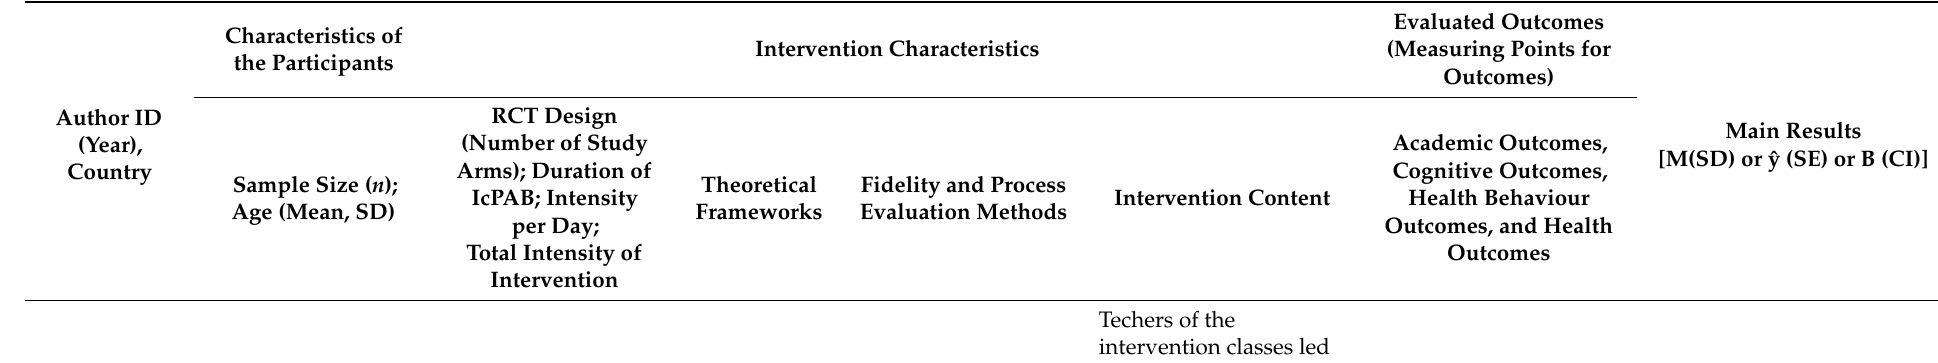
Table 2. Summary of selected studies (k =